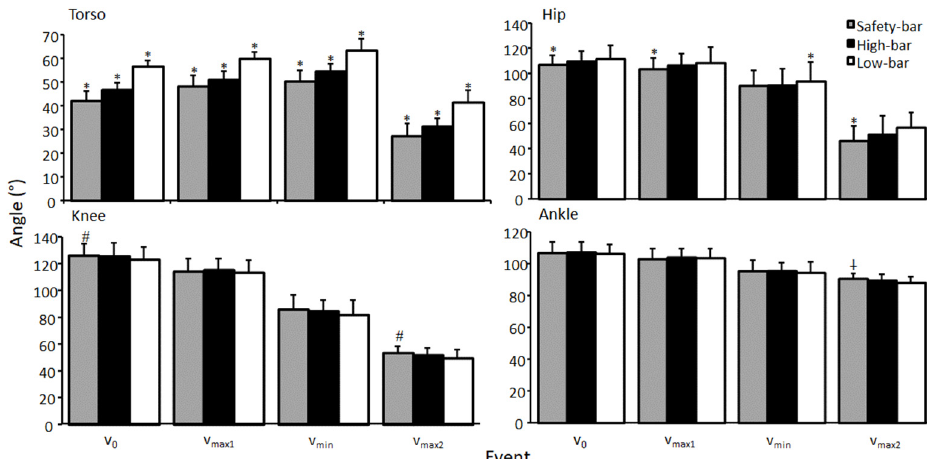
Figure 3. Mean ( ± SD) torso, hip extension, knee extension, and ankle flexion angle at the events v max1 , v min , and v max2 for the high-bar, low-bar, and safety-bar squat during 3-RM. * indicates a significant difference between this squat condition and all other squat conditions on a p ≤ 0.05 level. # indicates a significant difference between this squat condition and the low-bar condition on a p ≤ 0.05 level. † indicates a significant difference between this squat condition and low-bar condition on a p ≤ 0.05